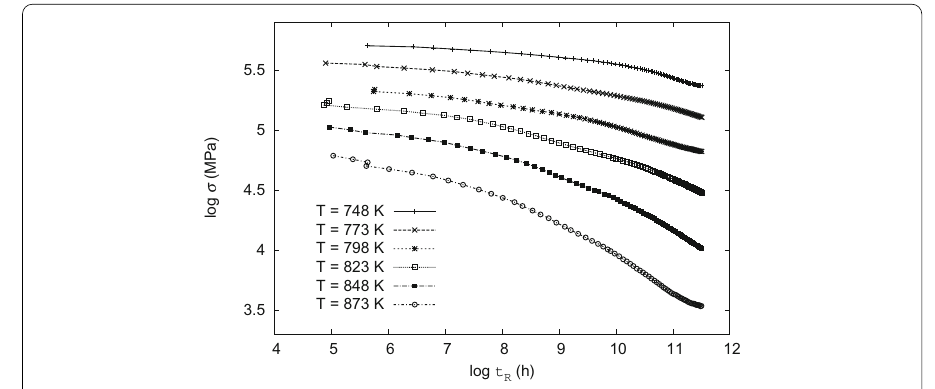
Fig. 4 Experimental stress vs. rupture at different temperatures, see Ref. [61]